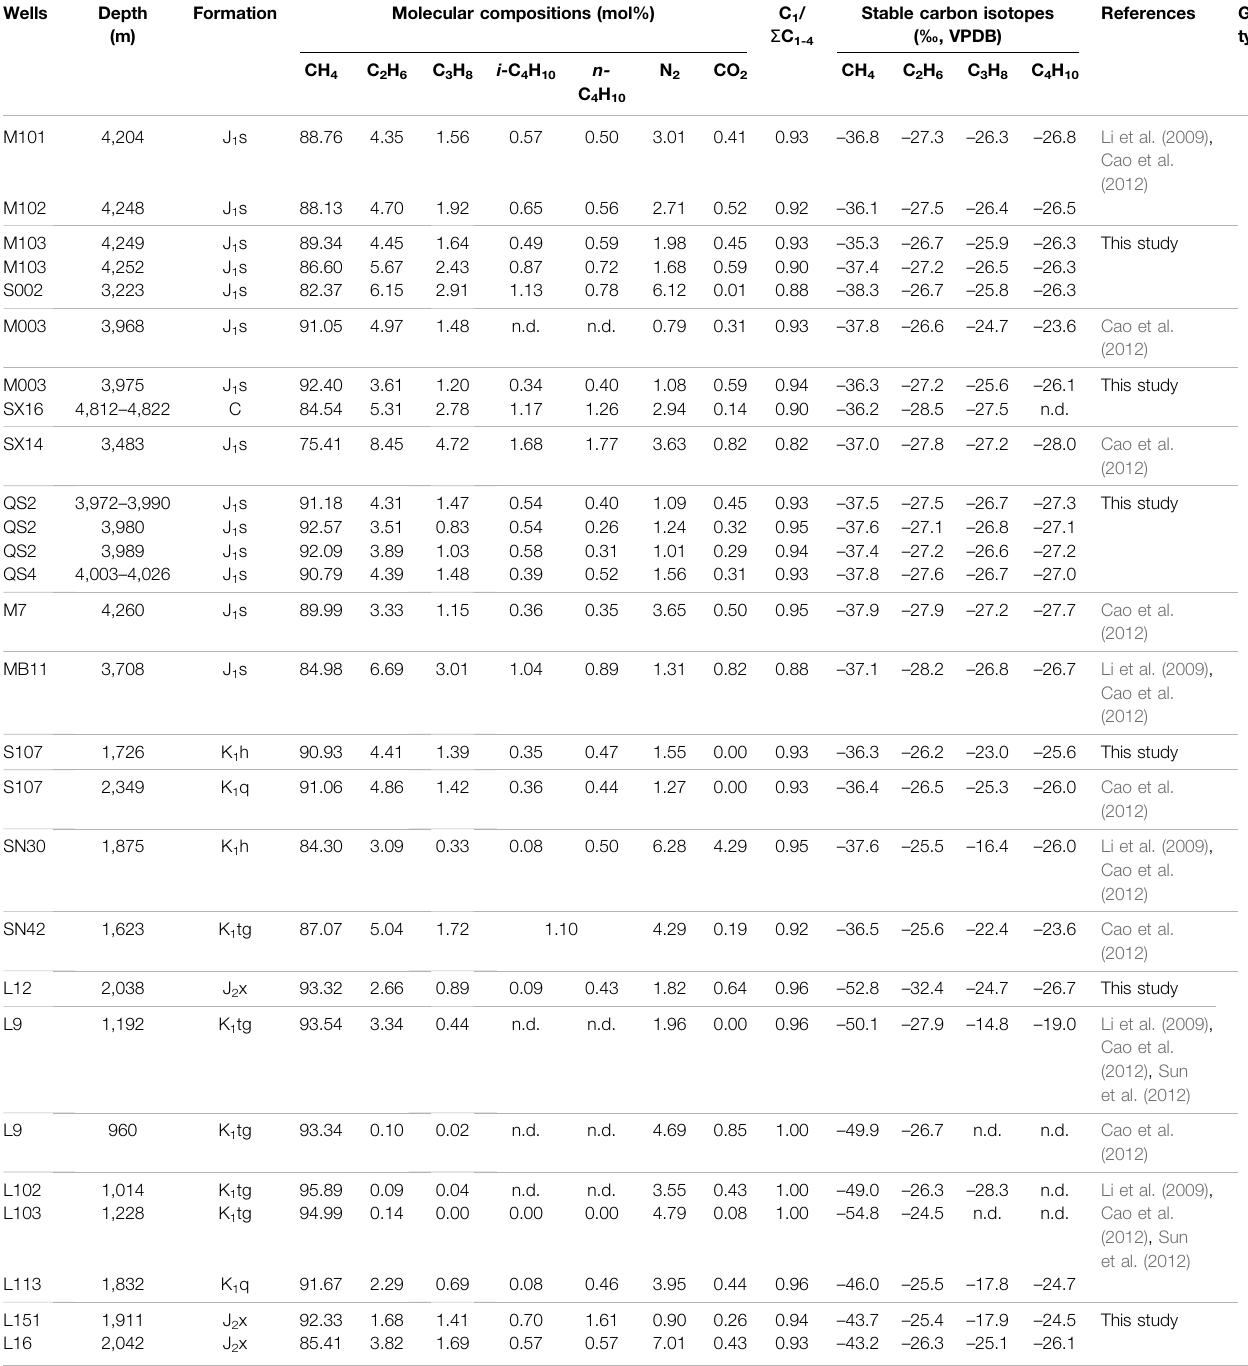
TABLE 1 | ( Continued ) Molecular and stable carbon isotopes of natural gases in the central Junggar